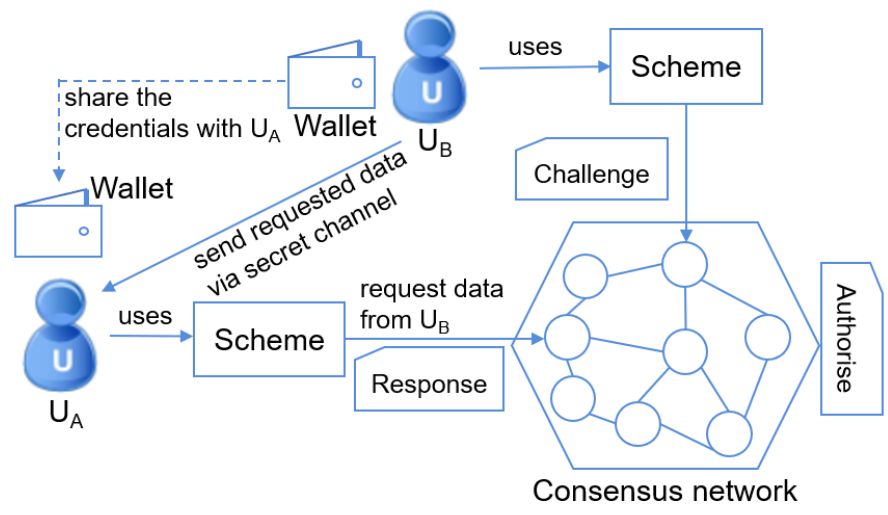
Figure 2. The system model of our proposed Challenge-Response Assisted Access Authorisation (CRA 3 )